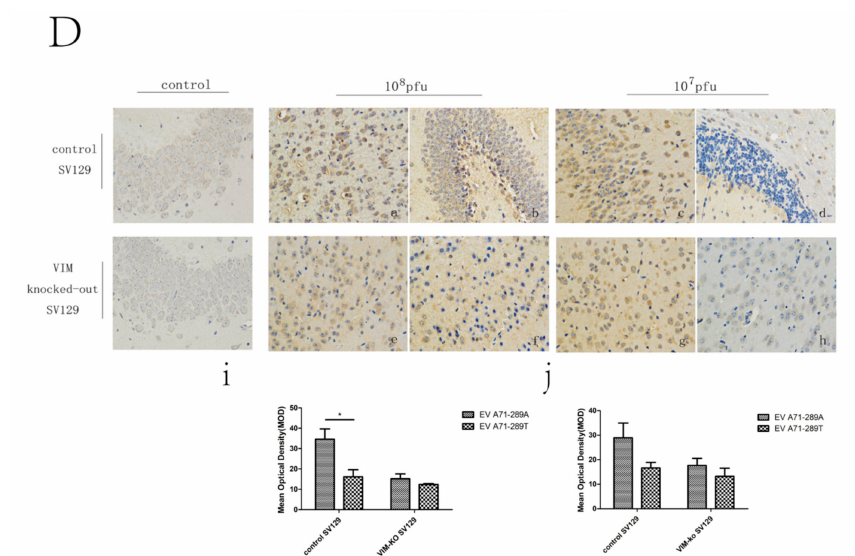
Figure 5. Brain damage detected via histopathological and immunohistochemical analyses in BALB / c mice and SV129 mice after infection with EV-A71-289A and EV-A71-289T. Brain damage detected via histopathological and immunohistochemical analyses in BALB / c mice. ( A ) a, b, c, d: Histopathological analysis of BALB / c mice infected by EV-A71-289A and EV-A71-289T at 10 7 pfu / mL. The arrows indicate neuronal damage or lymphocyte infiltration. e, f: Immunohistochemical analysis of BALB / c mice infected by EV-A71-289A and EV-A71-289T at 10 8 pfu / mL. The arrows indicate the positive staining of EV-A71; g: Denote the Mean of Optical Density (MOD) of staining intensity of IHC analysis in BALB / c mice infected by EV-A71-289A and EV-A71-289T at 10 8 pfu / mL. The 50% tissue culture infectivity dose (TCID50) value of cerebrospinal fluid of BALB / c mice intraperitoneally inoculated with 10 8 pfu / mL of the virus ( B ). Brain damage detected via histopathological analysis in SV129 mice. ( C ) a,c,e,g